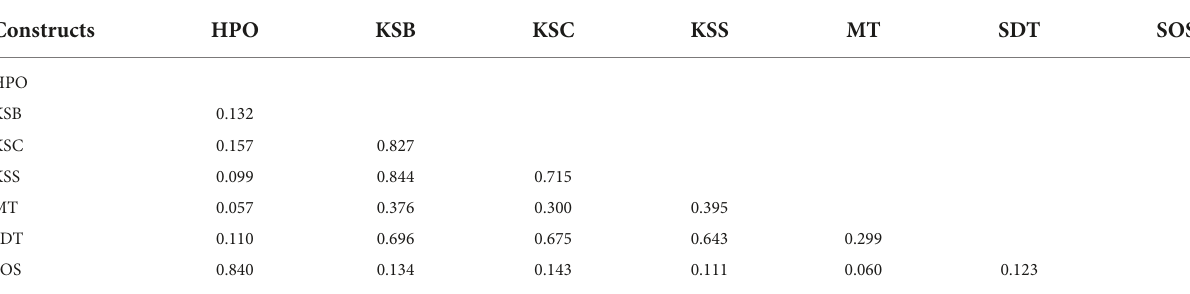
TABLE 4 Discriminant validity Heterotrait-Monotrait ratio (HTMT)